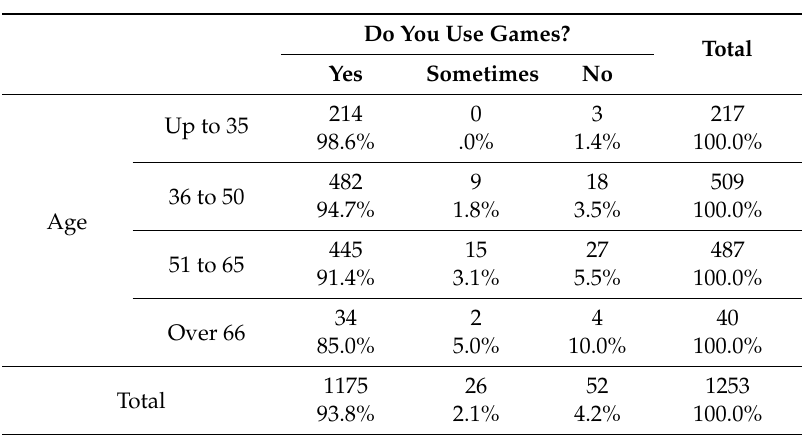
Table 3. Age and games.